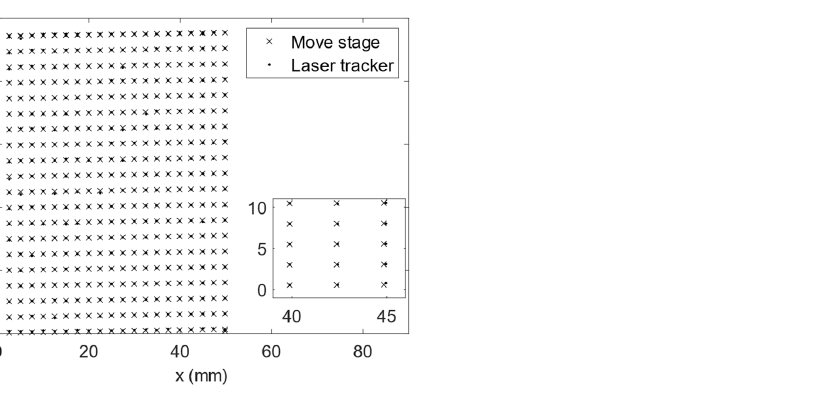
Figure 7. Move stage commands with coordinate change versus laser tracker measurements.